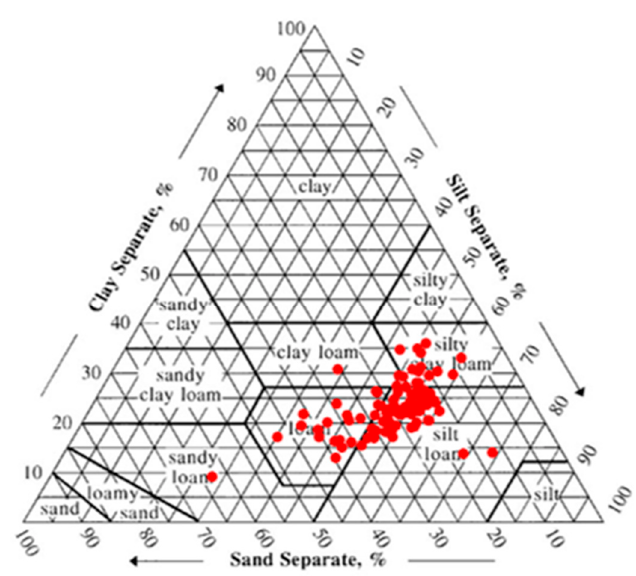
Figure 7. The soil types of the studied fields in the texture triangle.